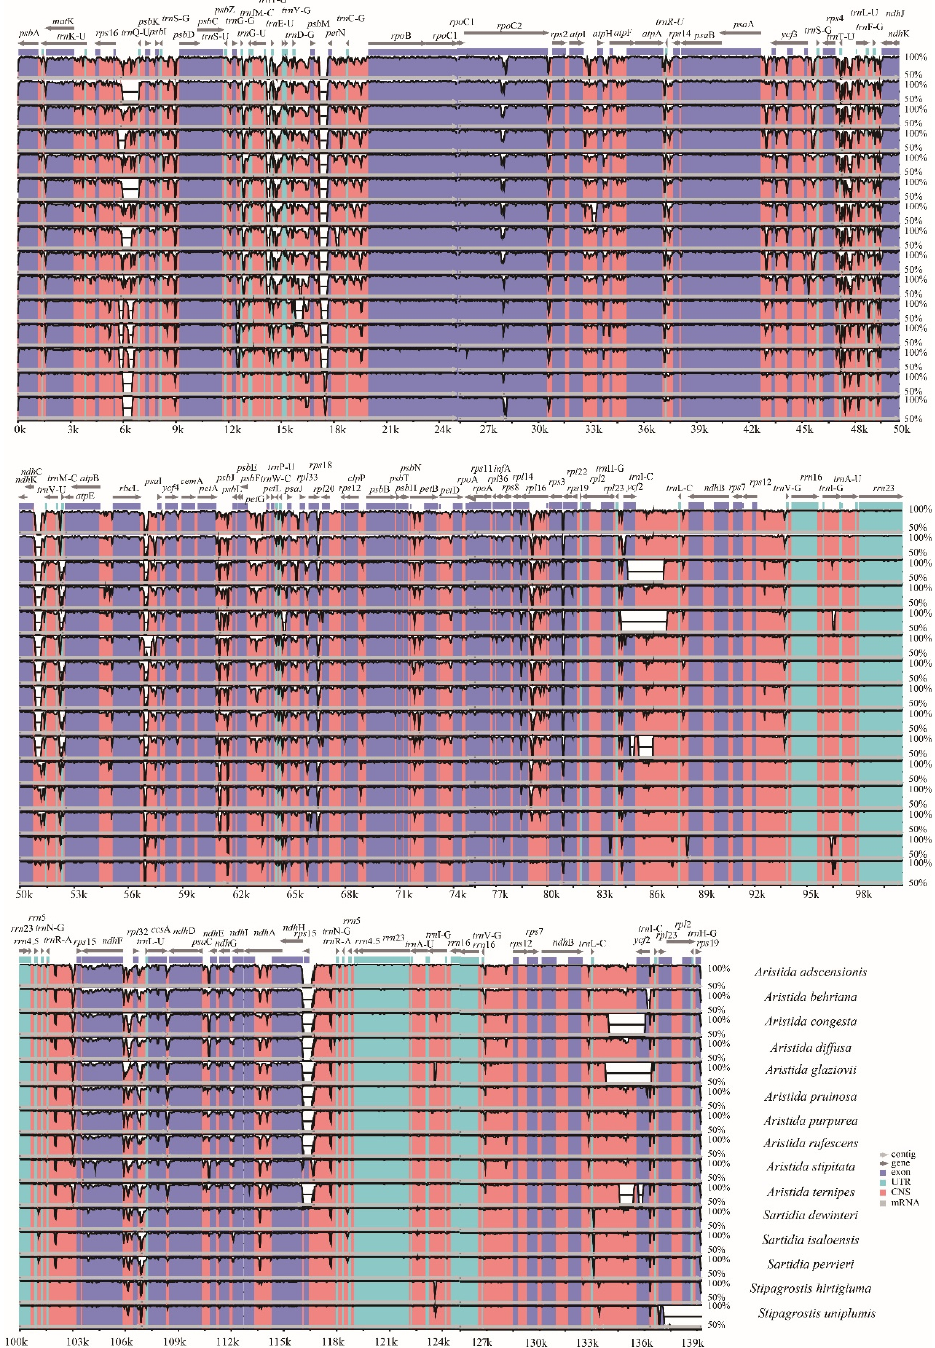
Figure 5. The homologous comparison of 16 Aristidoideae plastomes by mVISTA, with St. pennata as a reference. The horizontal axis, which represents the percentage of identity, ranges from 50–100%. Different colors indicate different gene